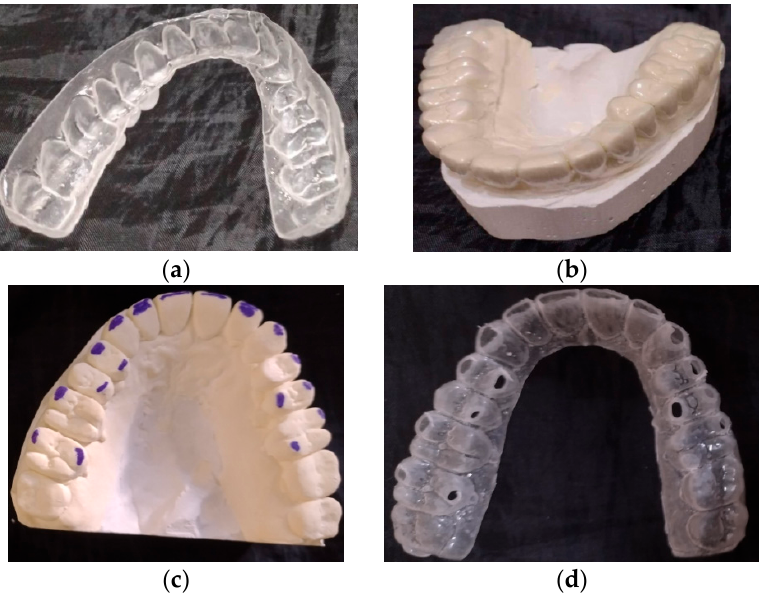
Figure 2. ( a ) Occlusal splint for the treatment of bruxism; ( b ) Splint placed on the model; ( c ) Model with marking of places where the splint damage occurs; ( d ) Worn splint during bruxism treatment.